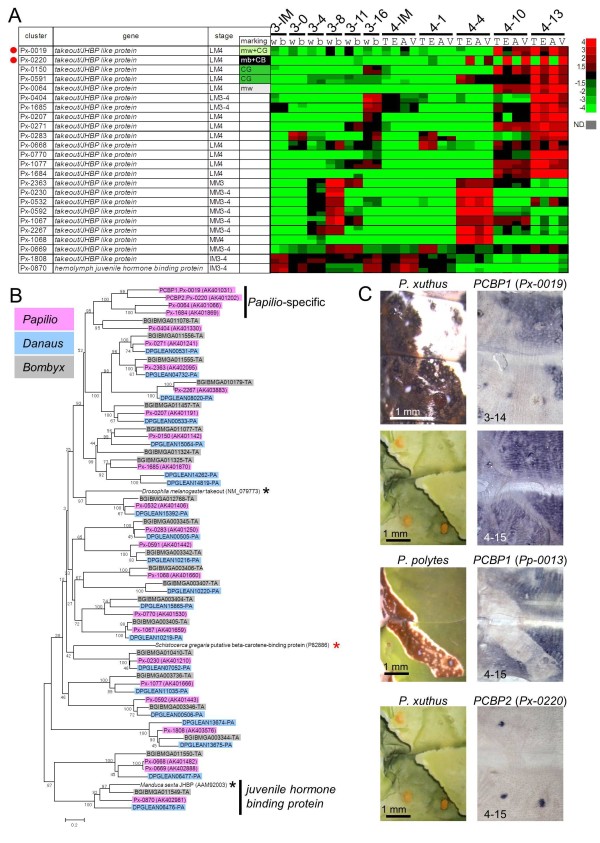
Expression pattern of putative carotenoid-binding protein genes. (A) Heat map of 24 takeout/juvenile hormone-binding protein (JHBP) family genes in P. xuthus. Red indicates positive values and green indicates negative values (color spectrum bar is shown to the right; N.D., not detected). Red circles indicate the genes examined by whole-mount in situ hybridization in (C). Stage and marking of each sample is shown above. The stage-specific co-expression cluster and marking specificity of each gene are also shown. See also Figures 2 to 4. (B) Neighbor joining tree of takeout/JHBP family genes based on their amino acid sequences. The numbers at the tree nodes represent the bootstrap values. The scale bars indicate the evolutionary distance between the groups. P. xuthus, D. plexippus and B. mori genes are shaded in red, blue and gray, respectively. Red asterisk indicates carotenoid-binding protein of locust Schistocerca gregaria, and black asterisks indicate takeout protein of Drosophila melanogaster and JHBP of Manduca sexta. Accession numbers are shown in parenthesis. Predicted genes of D. plexippus and B. mori were from MonarchBase http://monarchbase.umassmed.edu/ and KAIKObase http://sgp.dna.affrc.go.jp/KAIKObase/, respectively. (C) Spatial expression patterns of two putative carotenoid-binding protein mRNAs in P. xuthus and P. polytes larvae during the fourth and the third molts. Numbers in each panel indicate molt stage-hours after head capsule slippage. JHBP: juvenile hormone-binding protein.